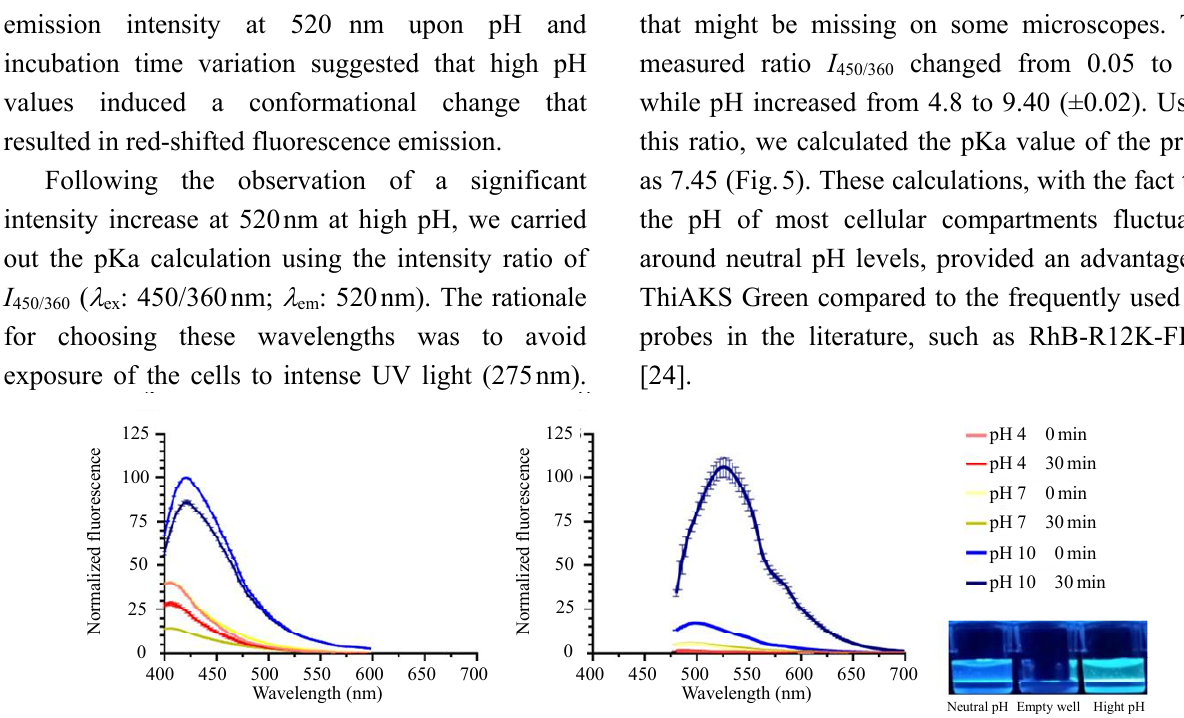
Fig. 6. The time dependent density functional